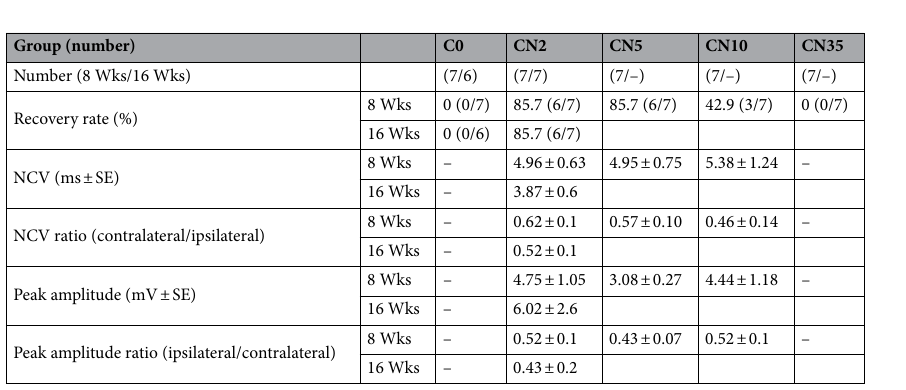
Table 1. The compound muscle action potentials of the gastrocnemius for the five test groups at 8 and 16 weeks after transplantation. NCV nerve conduction velocity, SE standard